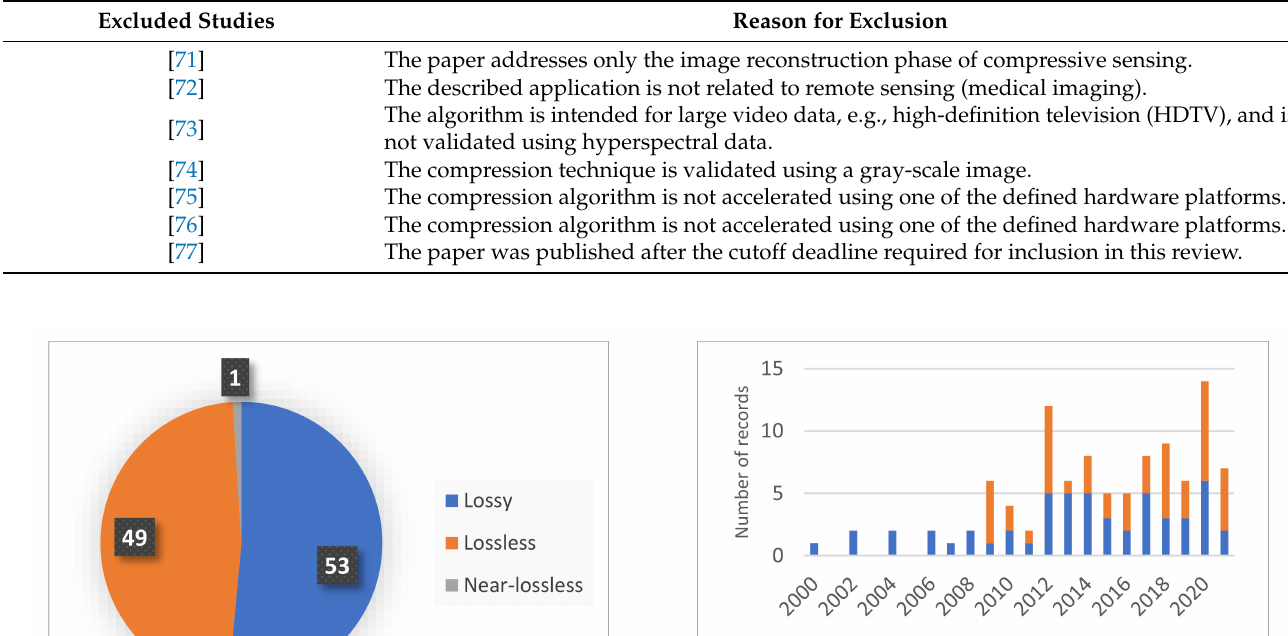
Table 2. List of studies excluded in this review using our search criteria. Excluded Studies